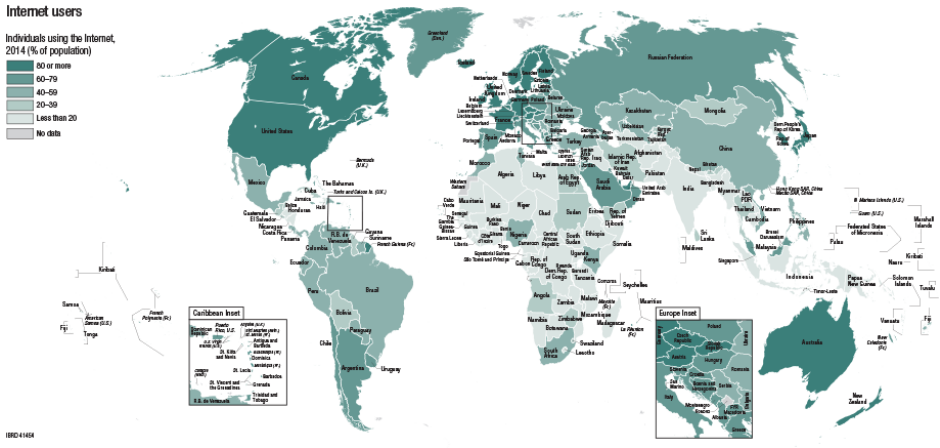
Figure 1. Internet/Web Access Not For All (Source: World Bank,